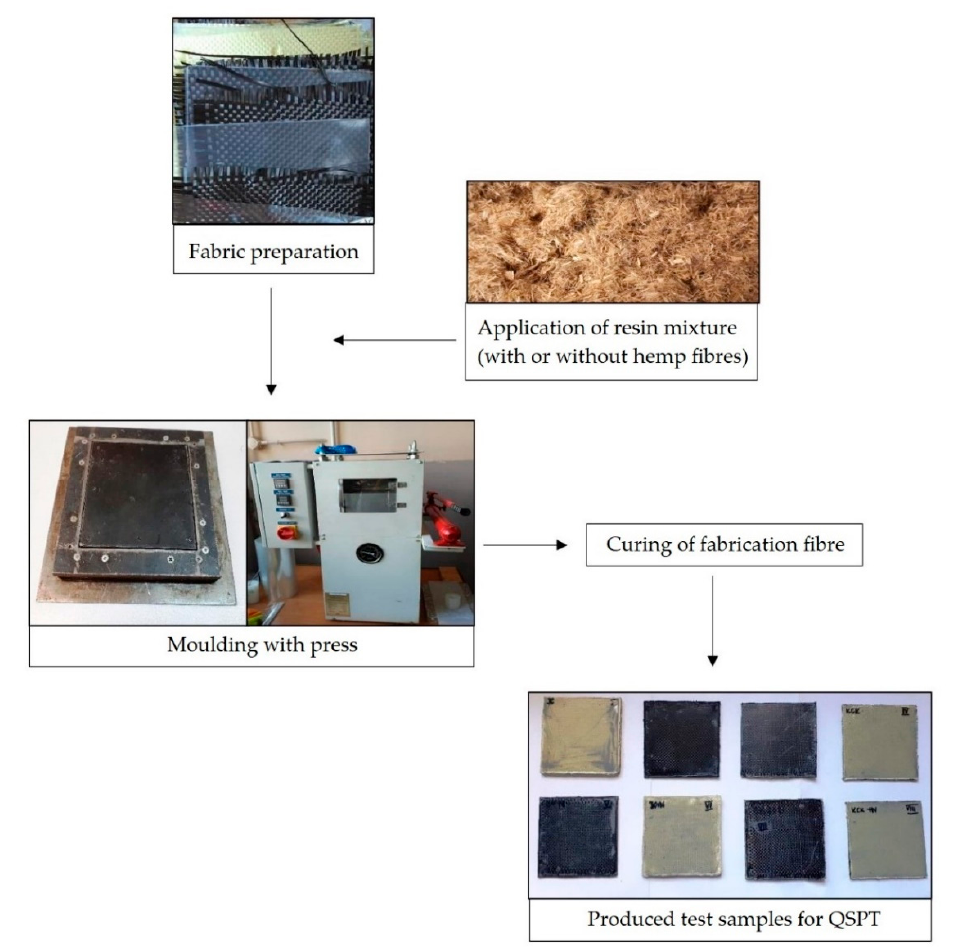
Figure 2. Production process of laminates.